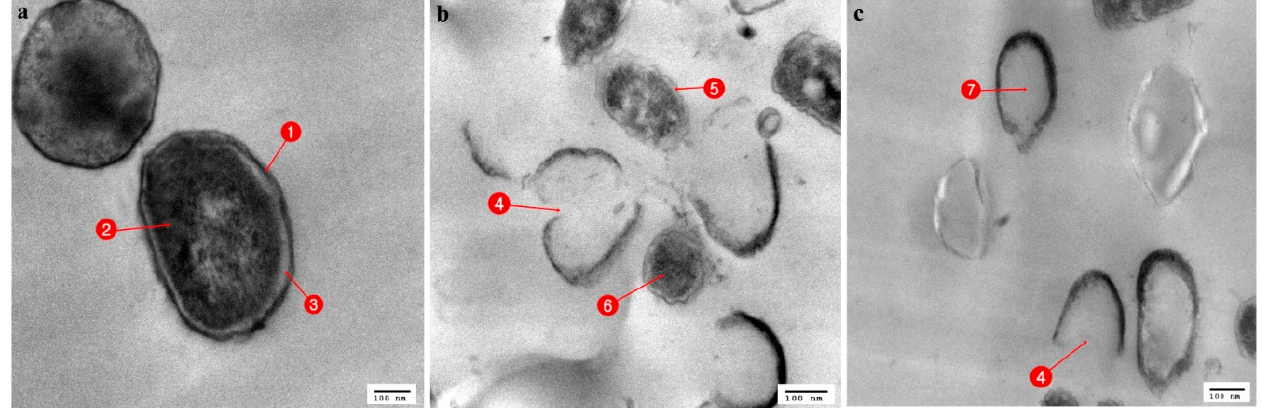
Figure 4. TEM micrograph of Streptococcus mutans ; ( a ) Normal cells: 1. Cell wall, 2. Homogenous cytoplasm, 3. Cell membrane; ( b ) cell affected with Stenotrophomonas maltophilia : 4. Cell rupture, 5. Damage of cell wall and membrane, 6. Leakage of cytoplasm; ( c ) cell affected with Serratia marcesens (15): 7. Empty cell.